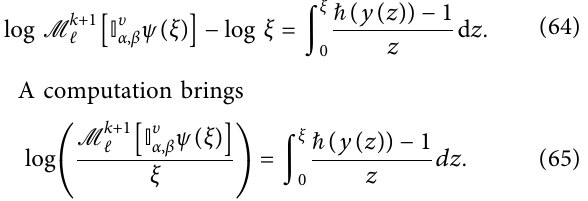
ψ ( ξ )] , when λ � 0 . 25 , c � α , β